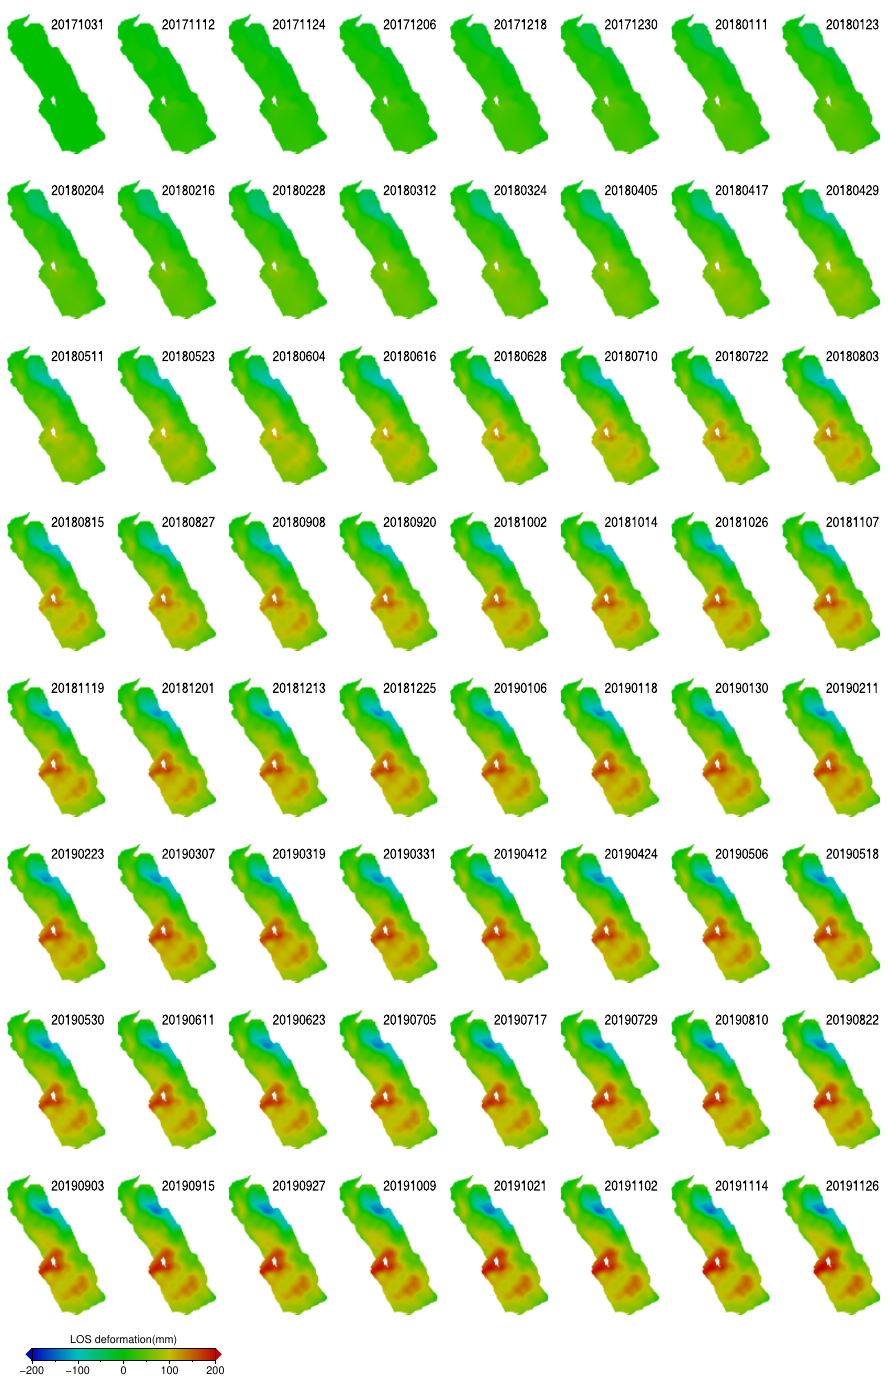
Figure 4. LOS displacement time-series maps for the Guang’an Village Landslide at the 128 Sentinel-1 acquisition date, referring to the first SAR image acquired on 31 October 2017 (from 31 October 2017 to 26 November 2019). The number at the upper right of each subplot represents the image acquisition date (in yyyymmdd